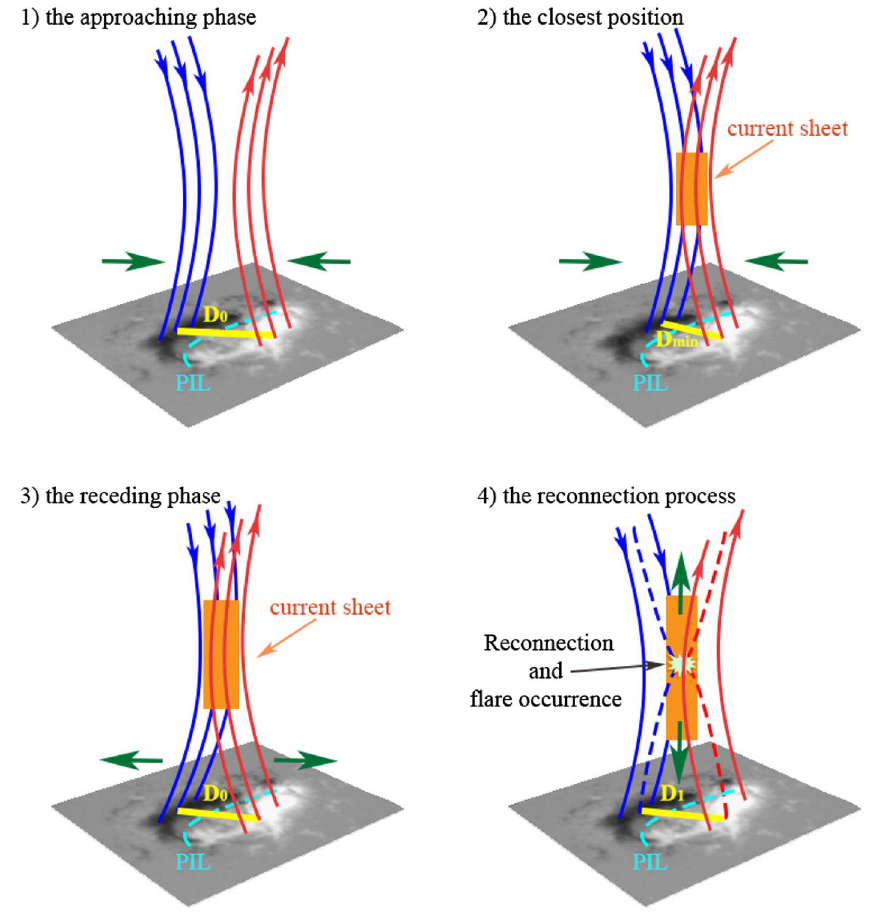
Fig. 6. Figure demonstrating the process (1) when two opposite polarities of initial barycenter separation distance D 0 are convergence; (2) the two opposite polarities are at their closest and a current sheet starts forming, where D min is the minimum distance, with D 0 > D min ; (3) the two opposite polarities are divergence from their closest distance, D min , back to D 0 , and the associated current sheet is still developing above the photosphere; (4) reconnection takes place and a fl are occurs above the polarity inversion line (PIL). After the distance between the polarity barycentres returns to the initial separation, D 0 , during a further evolution, this distance can now either decrease or increase (i.e., D 1 < D 0 or D 1 > D 0 ). D C = D 0 (cid:1) D min in Figure 5 (right